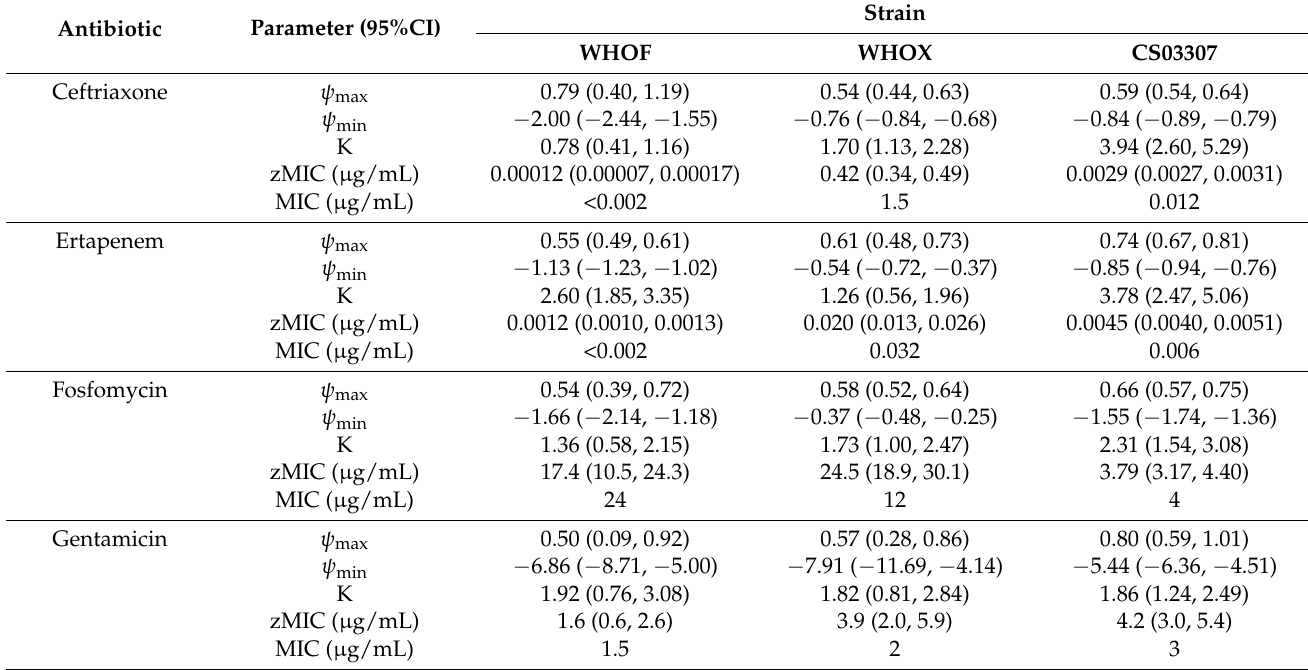
Table 1. Pharmacodynamic parameters estimated for each combination of strain and